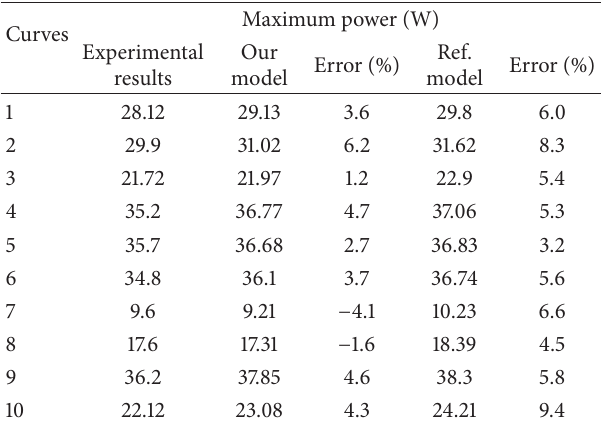
Table 5: Maximum power point of the solar